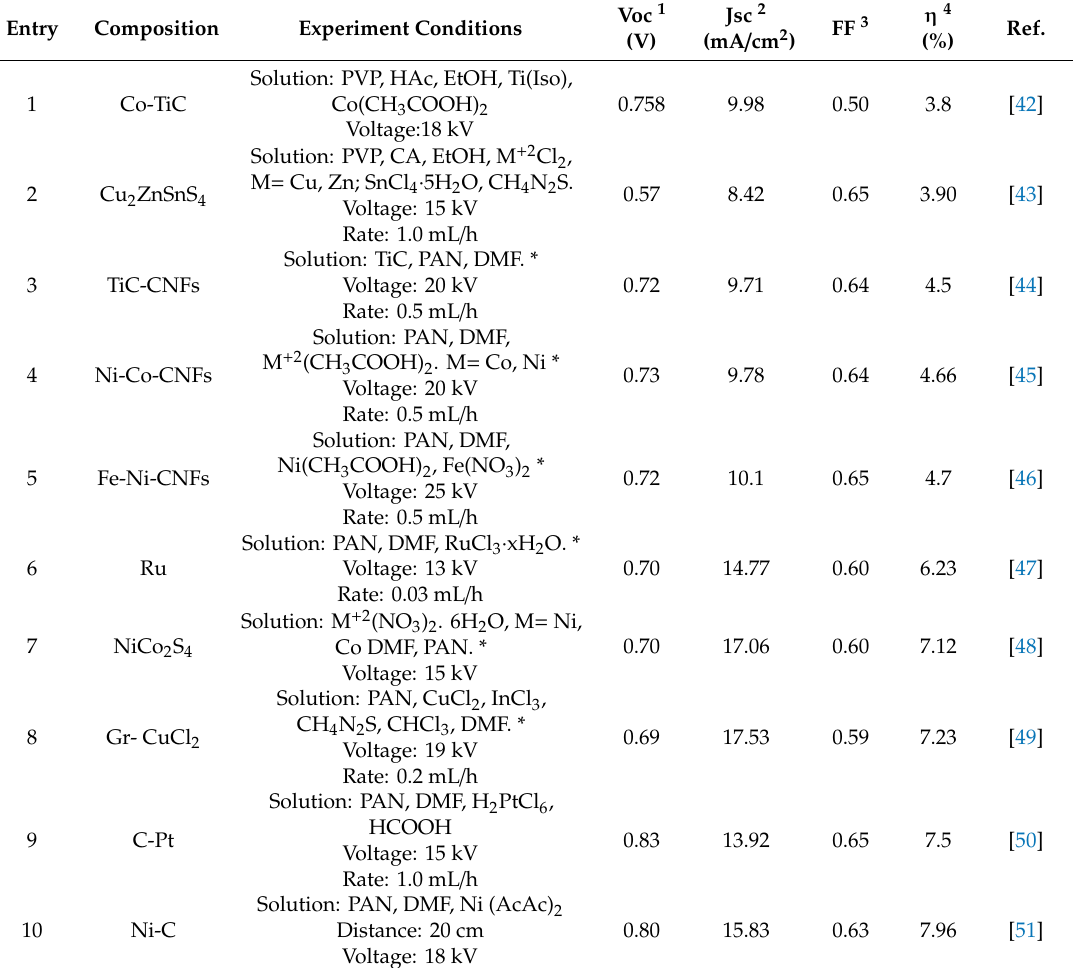
Table 2. Comparison of characteristics of electrospun nanofibers for counter